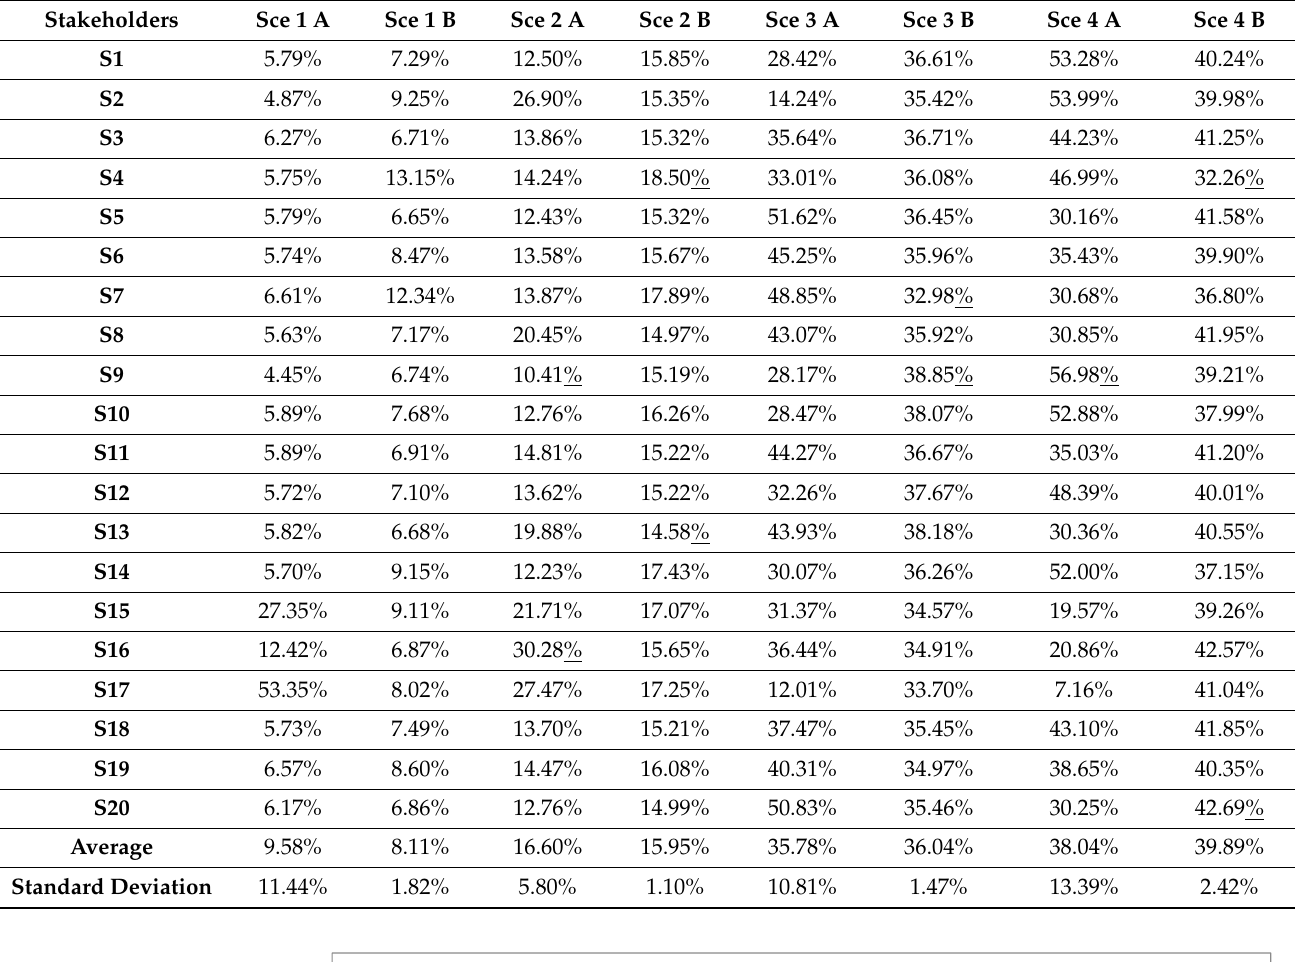
Table 5. Differences in results of MAMCA (A) and MAMCA with stakeholder weights (B).